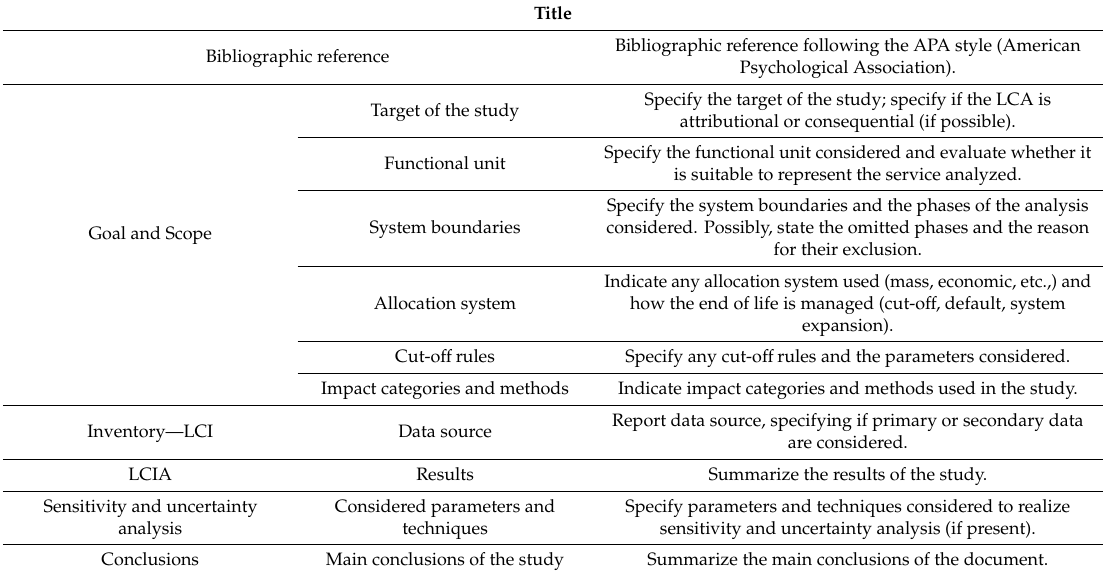
Table 1. Analysis scheme considered to evaluate literature review